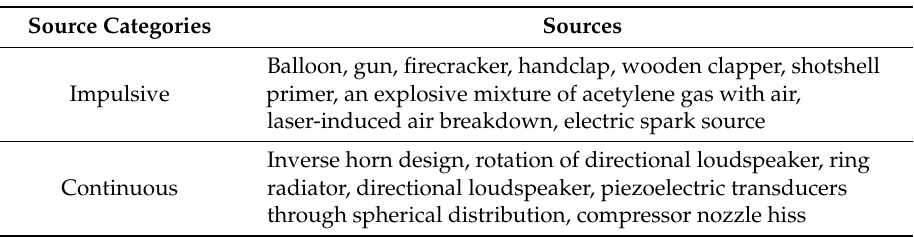
Table 4. Categorization of the